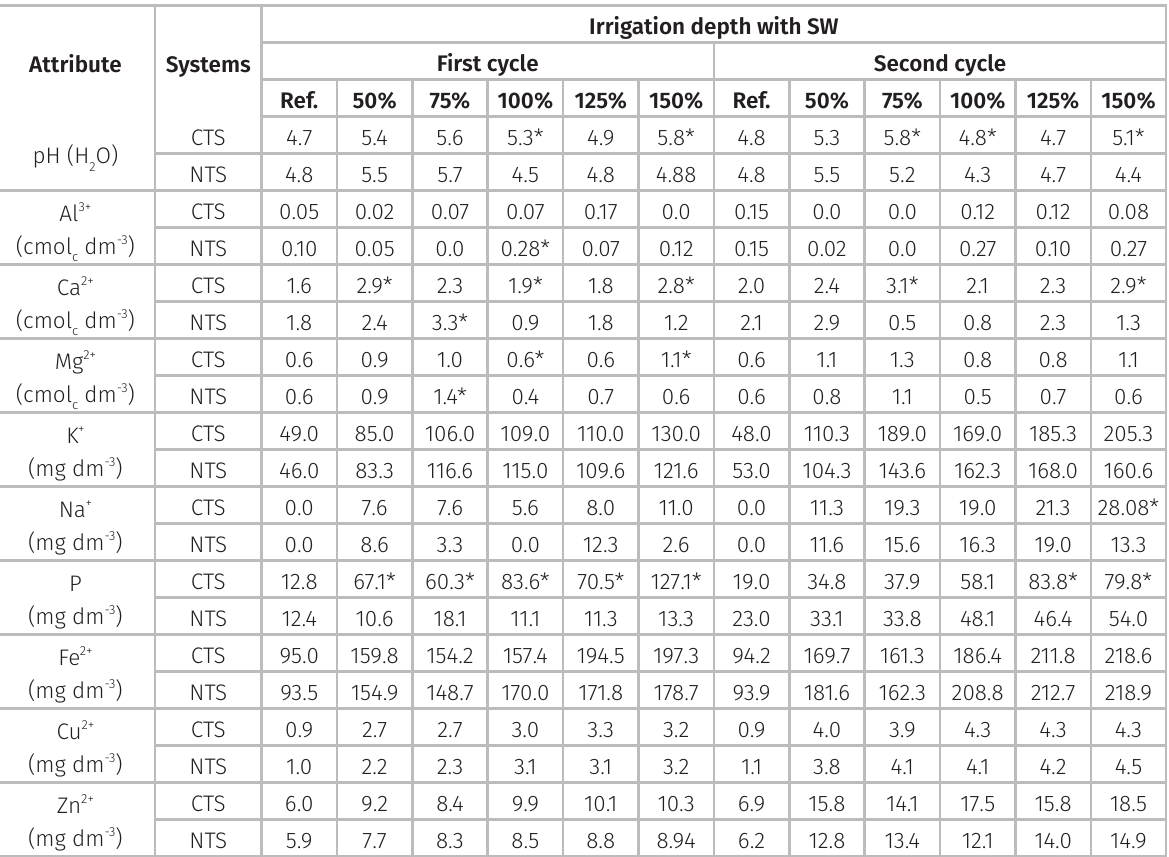
Table IV. Effect of different soil management systems (conventional tillage system – CTS and no-tillage system – NTS), within each depth of irrigation with SW, on pH, P, K, Na, Ca, Mg, Al, Fe, Cu and Zn values at a depth of 0.1–0.2